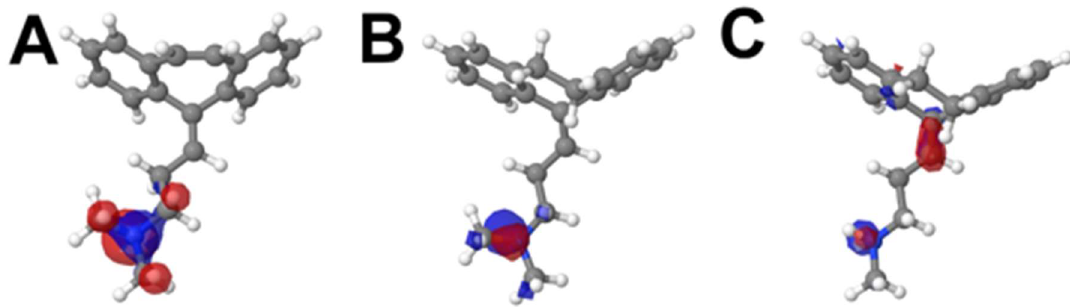
Figure 5. HOMO distribution of CBP ( A ), AMP ( B ) and NOR ( C ), in the molecules’ respective lowest energy conformers.